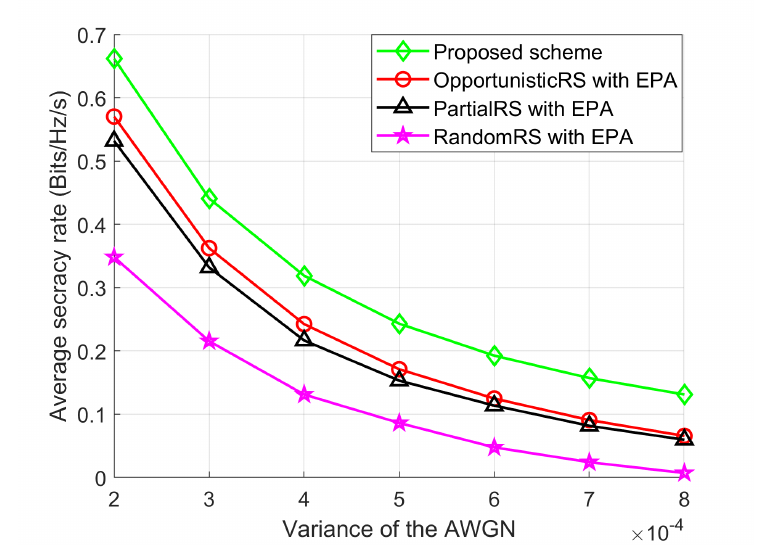
Figure 9. Average SR performance with σ 2 n